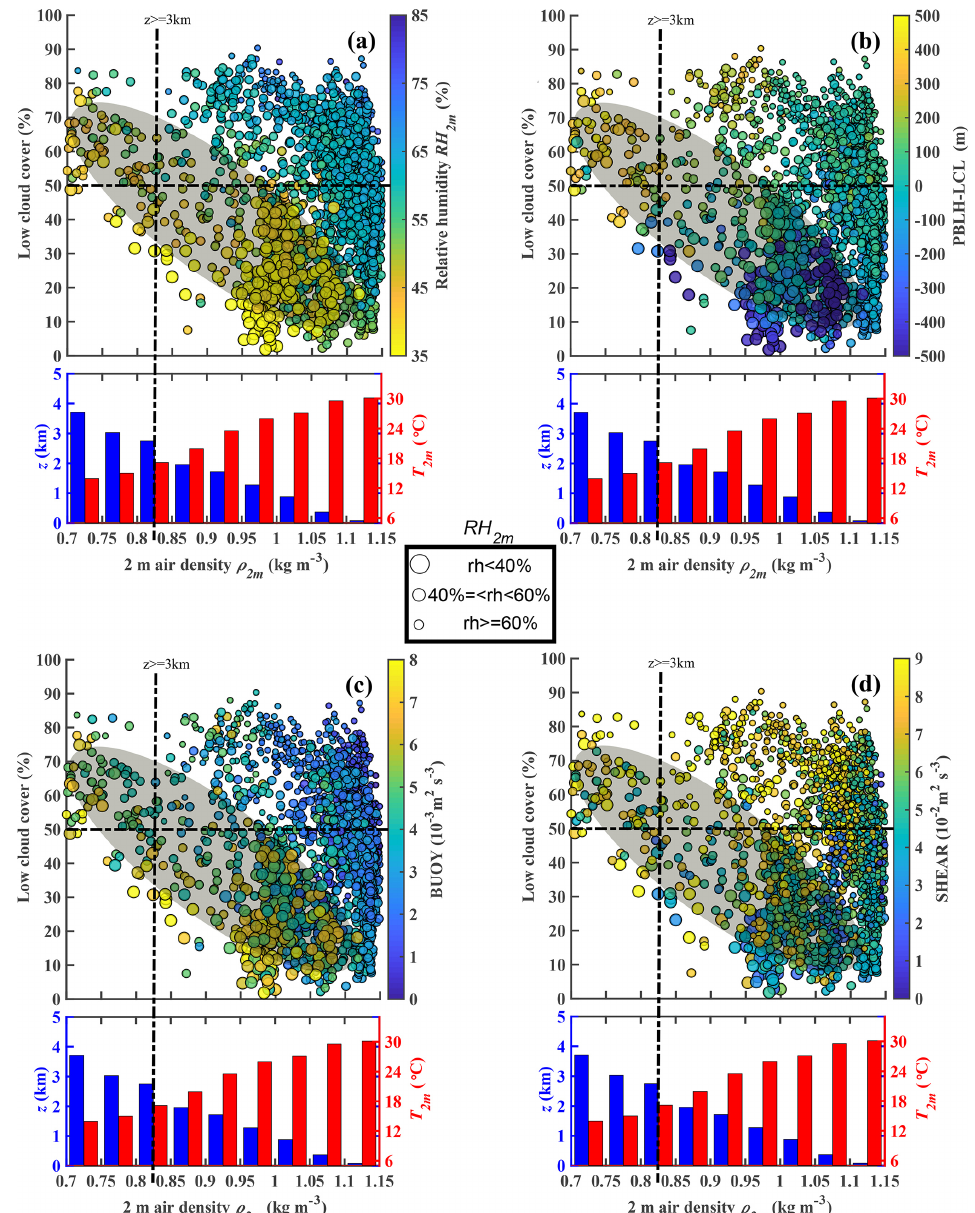
Figure 6. The relationships among monthly means of LCC, ρ 2m , and (a) RH 2m , (b) PBLH–LCL, (c) BT, and (d) ST at 14:00 Beijing time from 2010 to 2019 in summer in China. The samples are divided into three groups: RH 2m (cid:61) 60% (small-sized dots), 60% > RH 2m (cid:61) 40% (medium-sized dots), and RH 2m < 40% (large-sized dots). The LCC, T 2m , and RH 2m are observed by in situ measurements, and PBLH, LCL, BT, and ST are derived from ERA5 reanalysis data. Here we use the nearest-neighbor gridding method to derive PBLH, LCL, BT, and ST at each site. The blue and red histograms show the surface elevation z (blue) and air temperature at 2m ( T 2m ) (red) as functions of 2m air density ( ρ 2m ). The dots with lower RH 2m (RH 2m < 40%) are mostly distributed within grey-shaded elliptic regions as shown in panels (a) – (d)